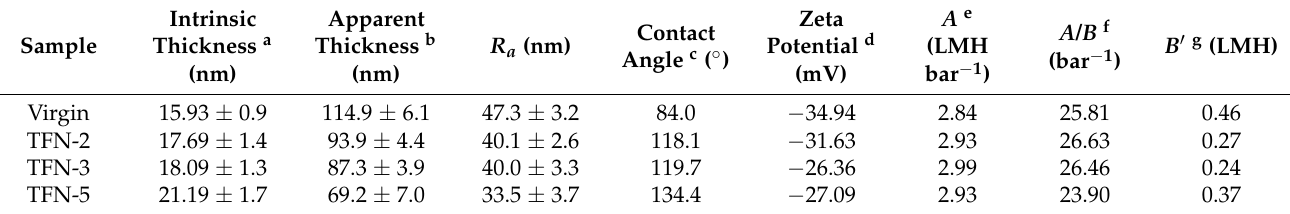
Figure 6. The comparison of intrinsic and apparent thickness in TEM images. Table 1. Data comparison of the TFC and TFN RO membranes.